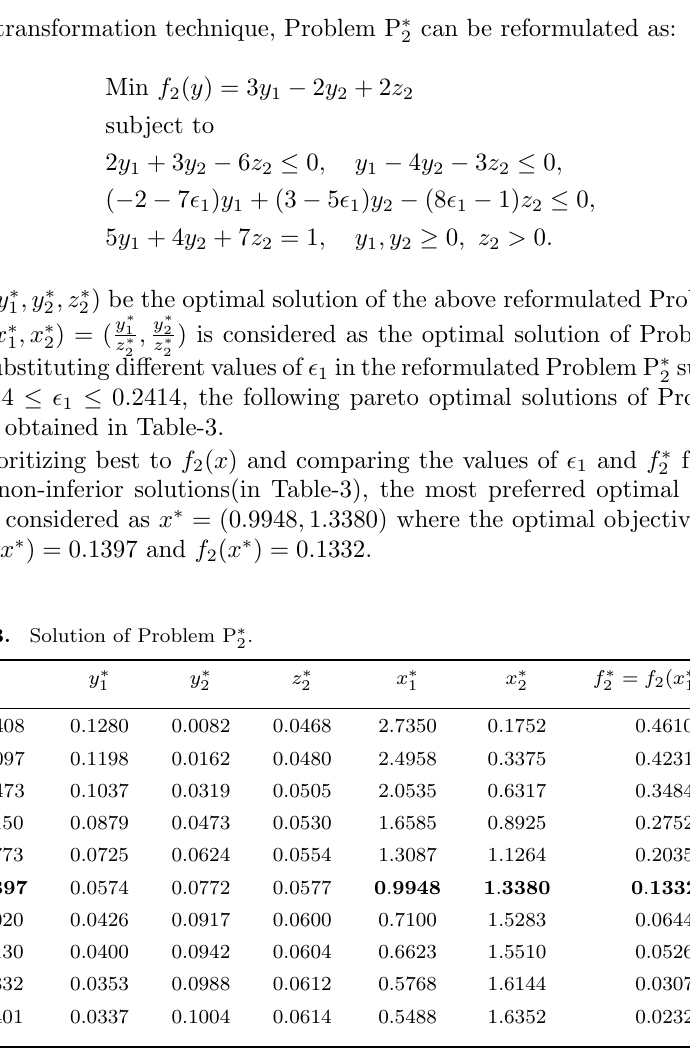
Table-2 and Table-3 represent the set of non-inferior or pareto optimal solu- tions of the given multi-objective LFPP from which the most preferred optimal solution is ascertained by the DM assigning highest priority to only one objec- tive function and accordingly optimal objective values are